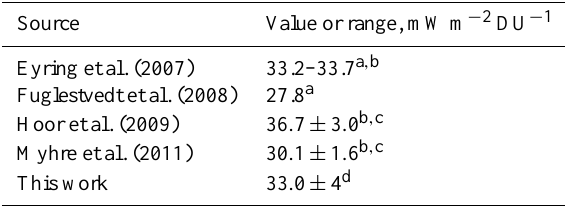
Table 1. Radiative efficiency of O 3 generated from ship NO x .